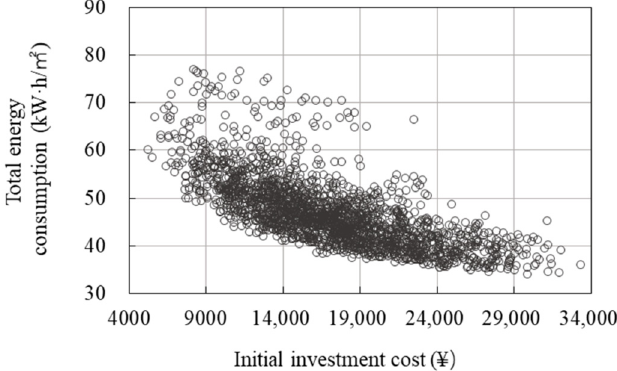
Figure 18. Iterative operation process of bi-objective optimization.